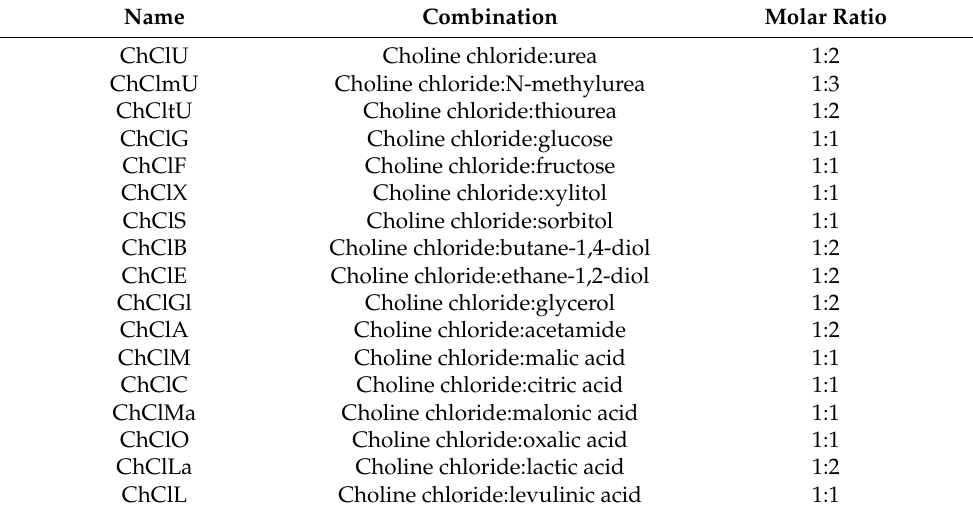
Table 4. Preparation of deep eutectic solvents